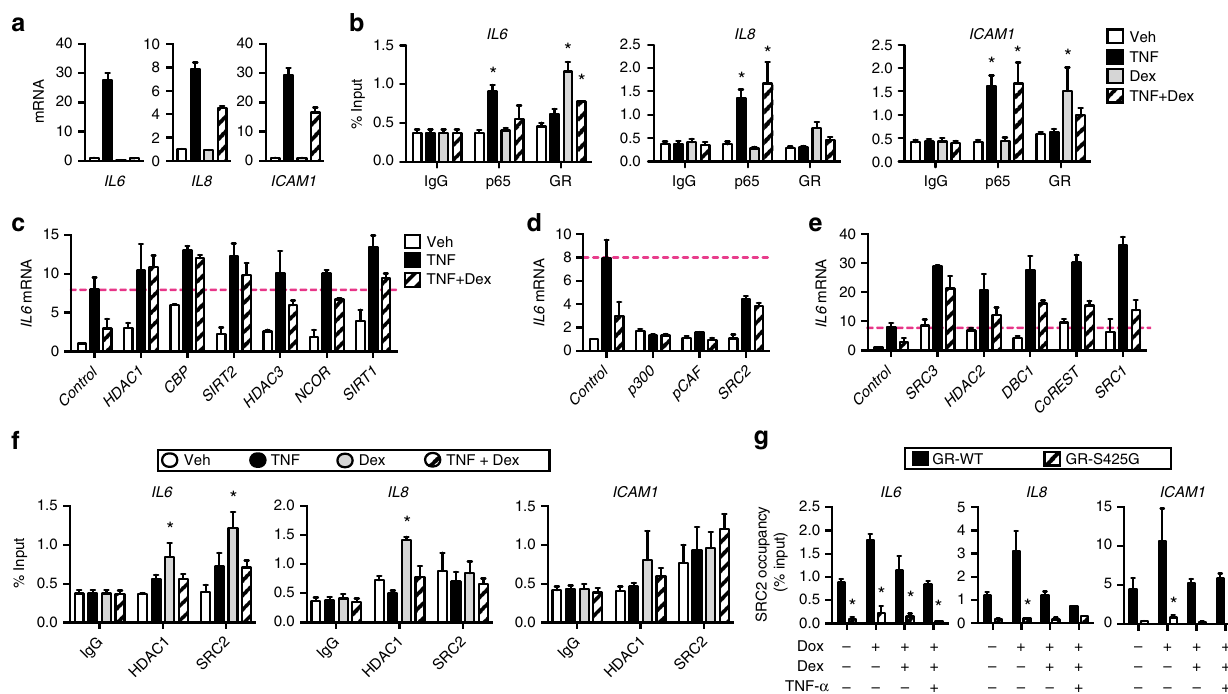
Fig. 7 Coregulators are essential for GR-mediated repression of NF- κ B. a , b Effects of dexamethasone (Dex) on NF- κ B target genes. Steroid-deprived MCF- 7 cells were stimulated with vehicle, 10 ng/ml TNF- α , 100 nM dexamethasone, or both. a After 4 h, total RNA was isolated and analyzed by qPCR. b The cells were fi xed after 1 h and promoter occupancies at IL6 , IL8 , and ICAM1 were compared by ChIP assay using anti-p65 NF- κ B or anti-GR antibody (mean ± SEM; n = 3). *Dunnett ’ s multiple comparisons test, p adj < 0.05 relative to vehicle-treated cells. c – e MCF-7 cells transfected with control or the